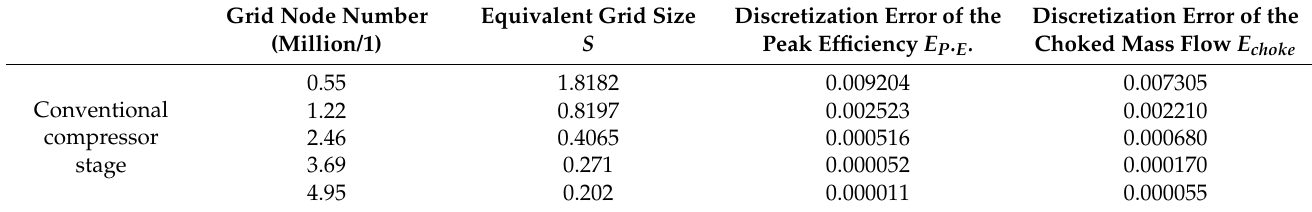
Table 4. Summary of grid numbers and discretization